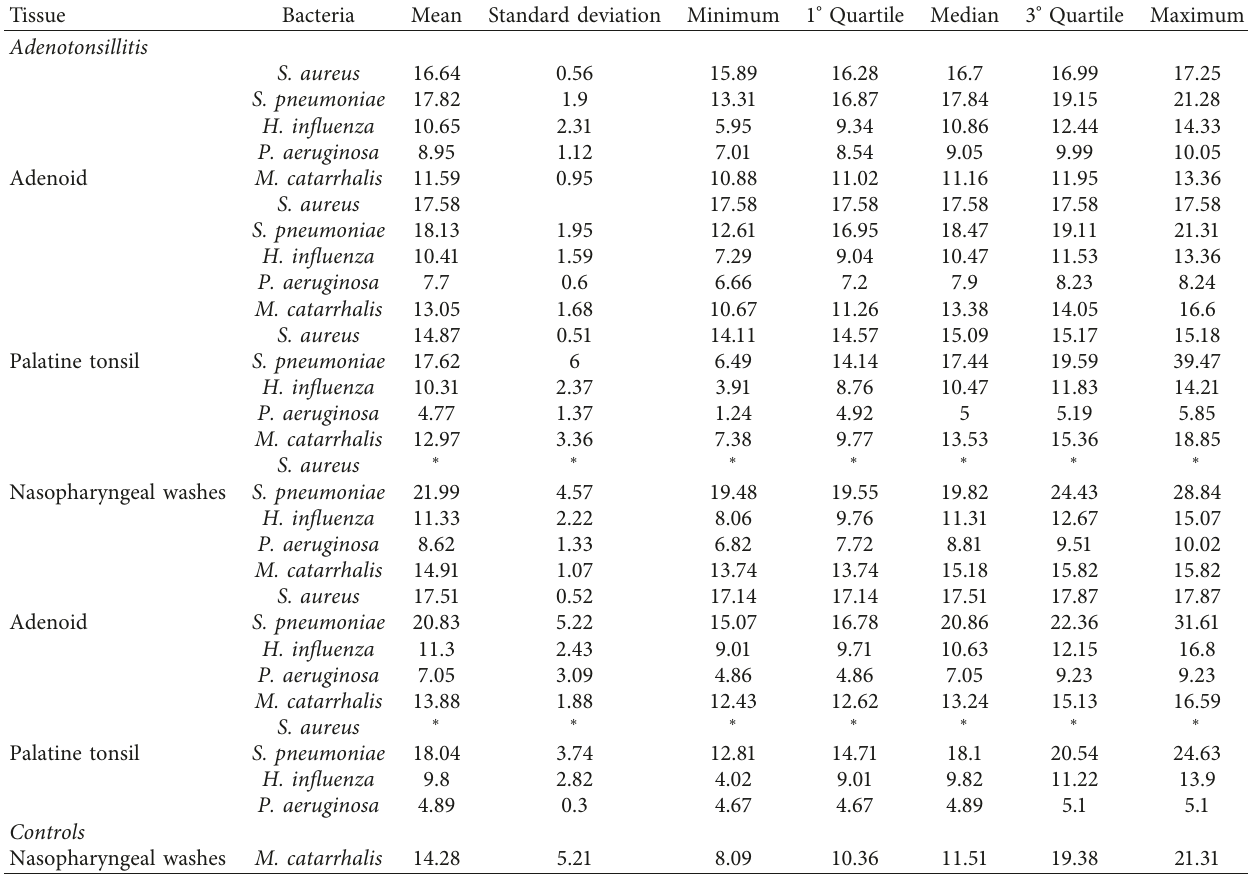
Table 4: Descriptive statistics for bacterial loads by group and